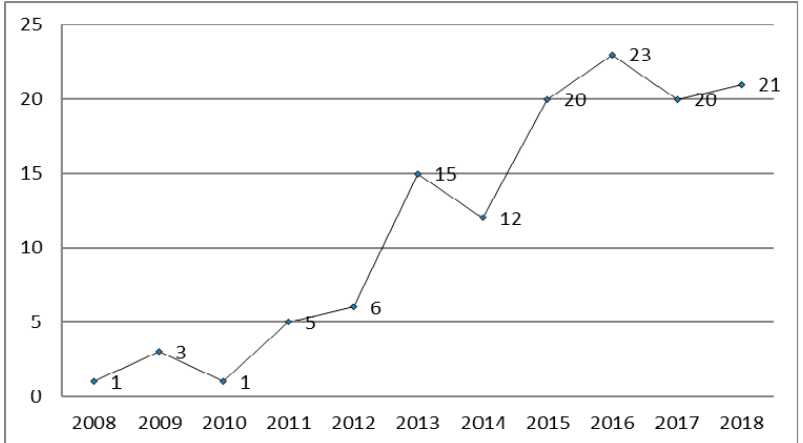
Figure 1. Yearly energy performance contracting (EPC)-related publications from 2008 to 2018.